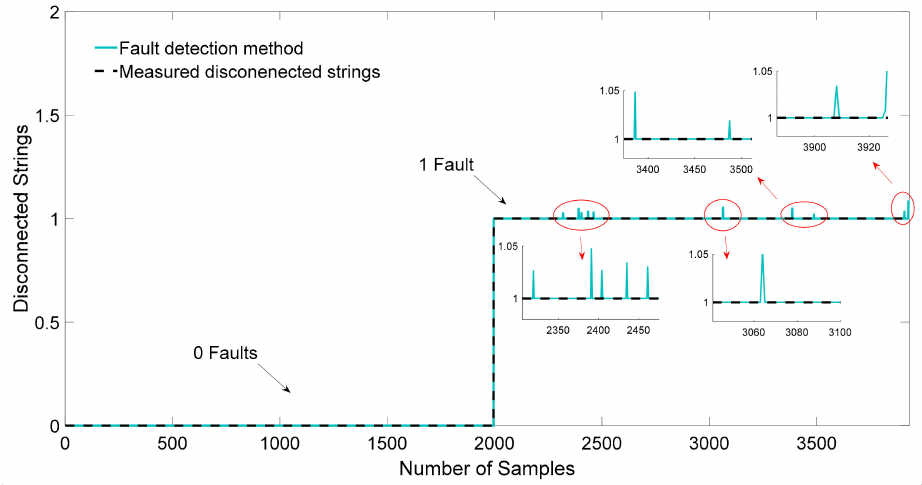
Figure 19. System 2 results using the neuro-fuzzy proposed